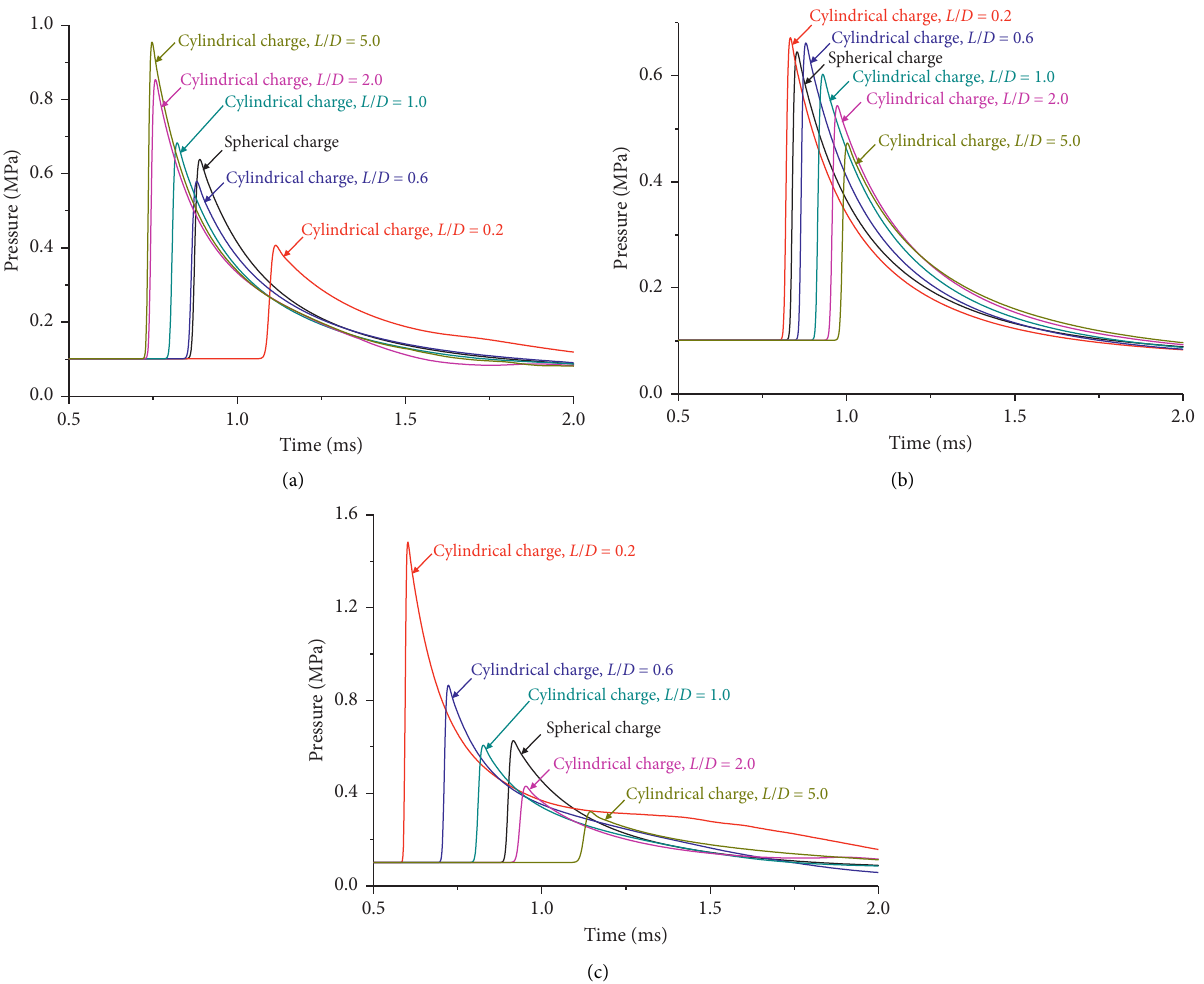
Figure 6: Comparison of pressure histories from spherical and cylindrical explosives. (a) Target 5 in radial direction. (b) Target 12 in 45 ° direction. (c) Target 19 in axial